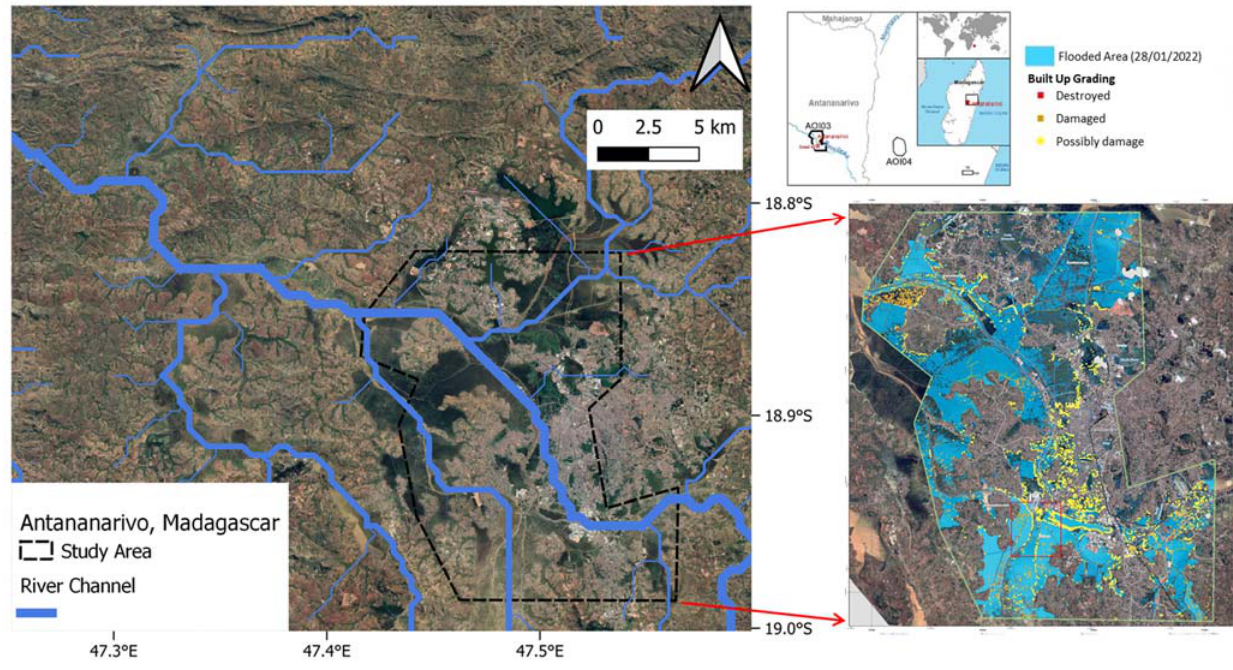
Figure 1. Study area and reference map.